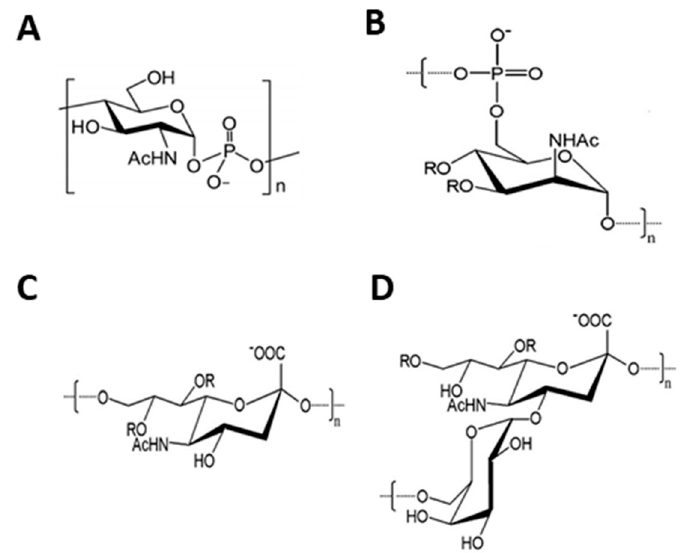
Figure 1. Monosaccharide units of N. meningitidis serogroup polysaccharides discussed in this review. ( A ) serogroup X; ( B ) serogroup A; ( C ) serogroup C; ( D ) serogroup W.